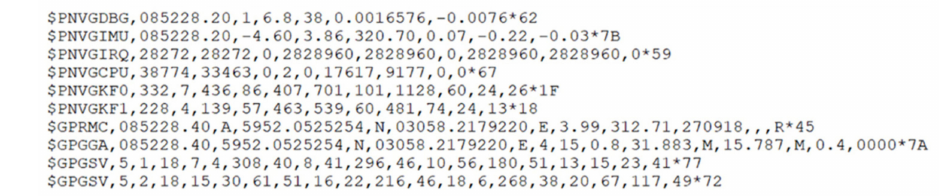
Figure 1. Sample data received from the first antenna.